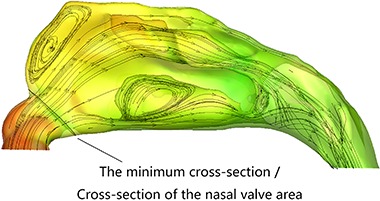
Transversal section of the nasal cavity. Circled area represents the minimum/total cross-section of the nasal valve area. The arrows show the air flow direction.